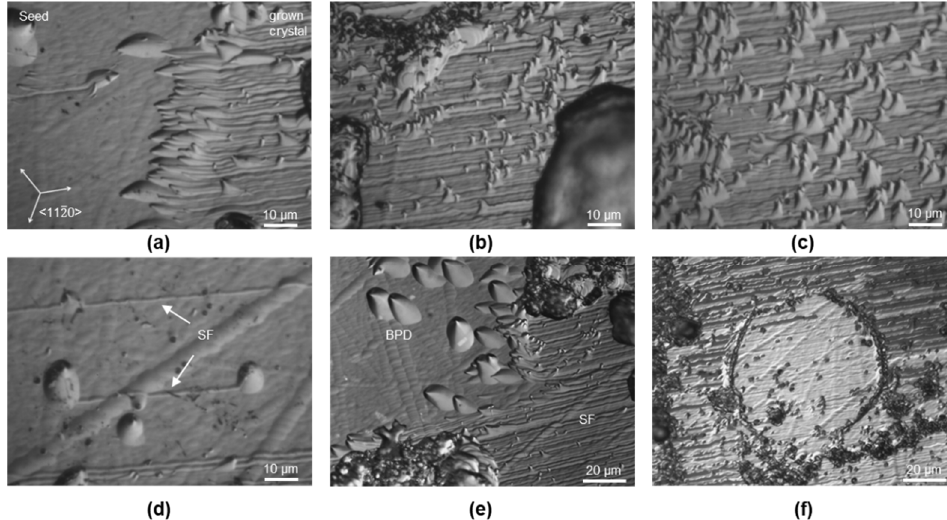
Figure 3. Microscopic images of the KOH-etched wafer taken from crystal A: ( a ) interface between seed and grown crystal; ( b – d ) images taken further to the right of the interface inside the area of the grown crystal; ( e ) two partial dislocations outlining a SF; ( f ) SFs interacting with dislocation pattern consisting of threading dislocations.